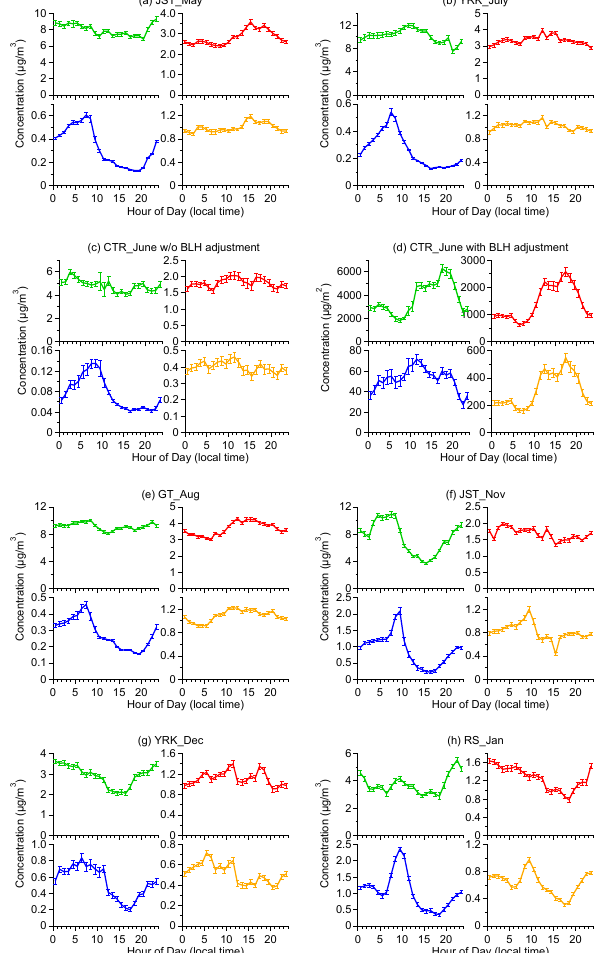
Figure 3. Diurnal profiles of non-refractory PM 1 (NR-PM 1 ) species measured by HR-ToF-AMS. Panel (d) shows the diurnal profiles of NR-PM 1 species after multiplying by the boundary layer height for the Centreville (CTR) site. The solid lines indicate the median concentration and the error bars indicate the standard